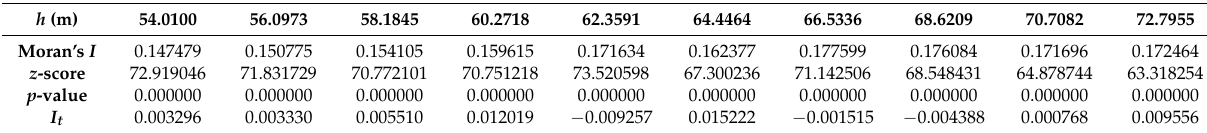
Table 7. Result of Moran’s I calculation according to cluster size at level